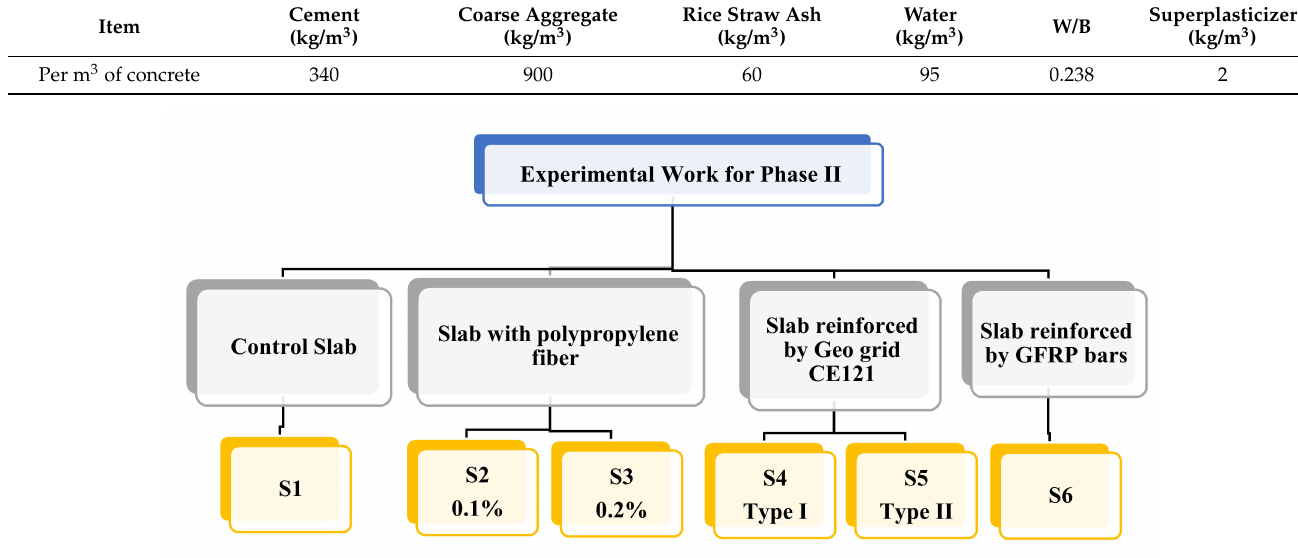
Table 9. Concrete mix design for Phase II.